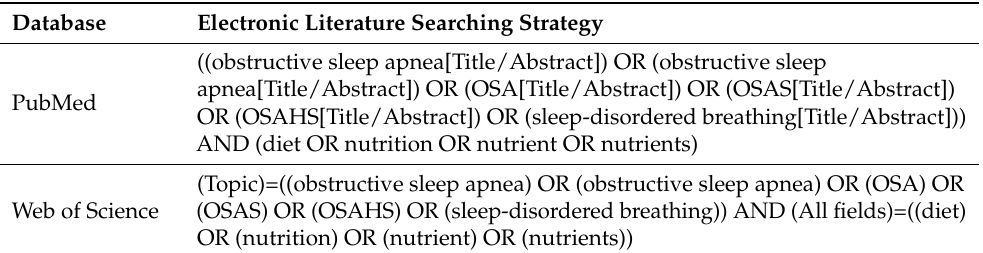
Table 1. Electronic literature searching strategies for PubMed and Web of Science databases applied within this